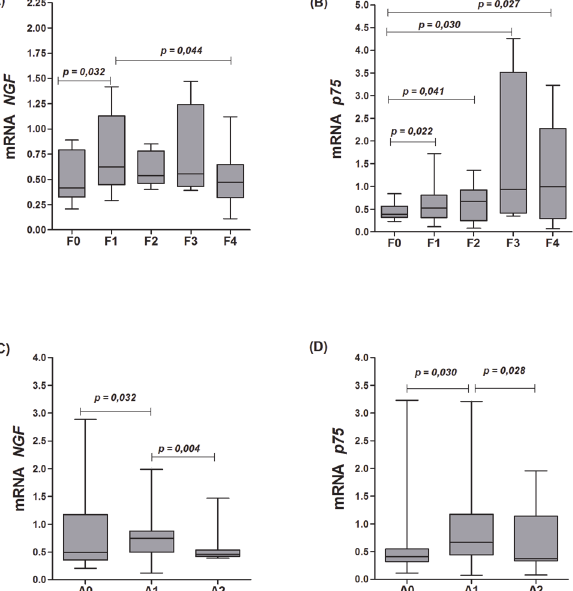
Fig 2. mRNA levels of NGF according to the clinical conditions of liver. A-D: mRNA levels of NGF and p75 NTR according to the stage of fibrosis (F0 to F4) and inflammatory activity (A0 to A2) in the livers of all individuals with liver disease in the study population.